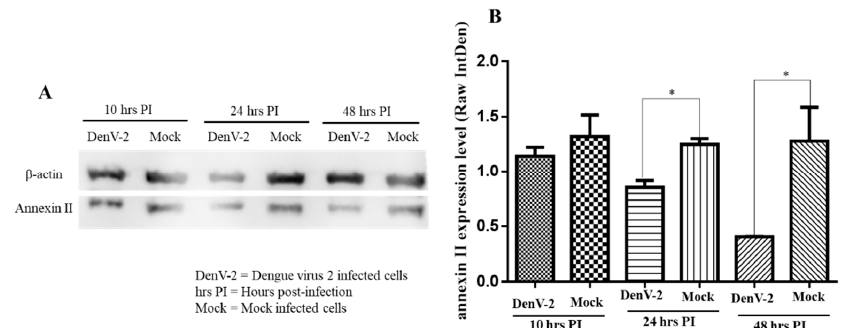
Figure 3. Expression of annexin II in plasma membrane fraction upon DENV2 infection. Vero cells were infected with DENV2 at MOI 2 or mock-infected and incubated for 10, 24, and 48 h. Plasma membrane was extracted, resolved by 12% SDS-PAGE, transferred onto the polyvinylidene difluoride (PVDF) membrane, and developed by electrochemiluminescence (ECL). ( A ) Immunoblots of annexin II expression levels at 10, 24, and 48 h post-infection with DENV2. ( B ) Annexin II band densitometry analysis from panel A. There were significant differences in the annexin II levels between the DENV2-infected and mock-infected Vero cells (* indicates p < 0.05) at 24 and 48 h post-infection, using the student t-test. Band densitometry analyses were undertaken using the ImageJ software, after normalization with β –actin (loading control). The value of the raw integrated density was plotted from the three independent experiments and the error bars represent the standard error of the means.